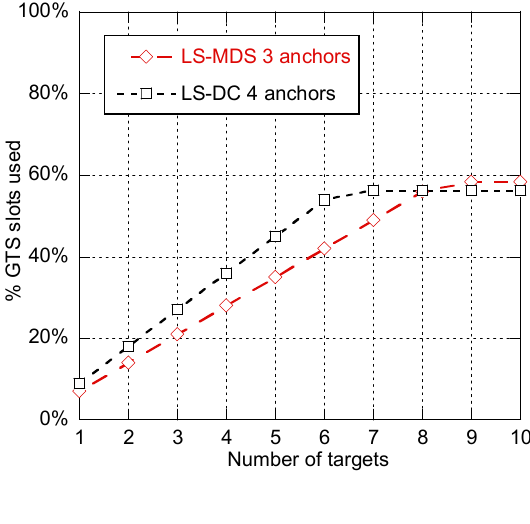
Figure 15. % of GTS slots used for location data transmission for LS-MDS (three anchors) and LS-DC (four